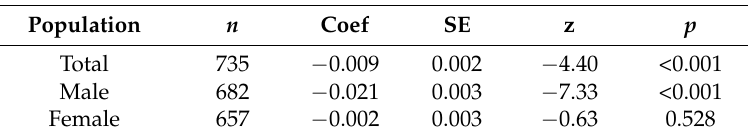
Table A2. Adjusted Poisson log-linear model with ln mean arsenic, >10% dependency, and ND = 1/(sqrt 2) × LOD, excluding states that had supplementary data in the Mendez dataset. [Mendez model, excluding states with “proprietary” data].